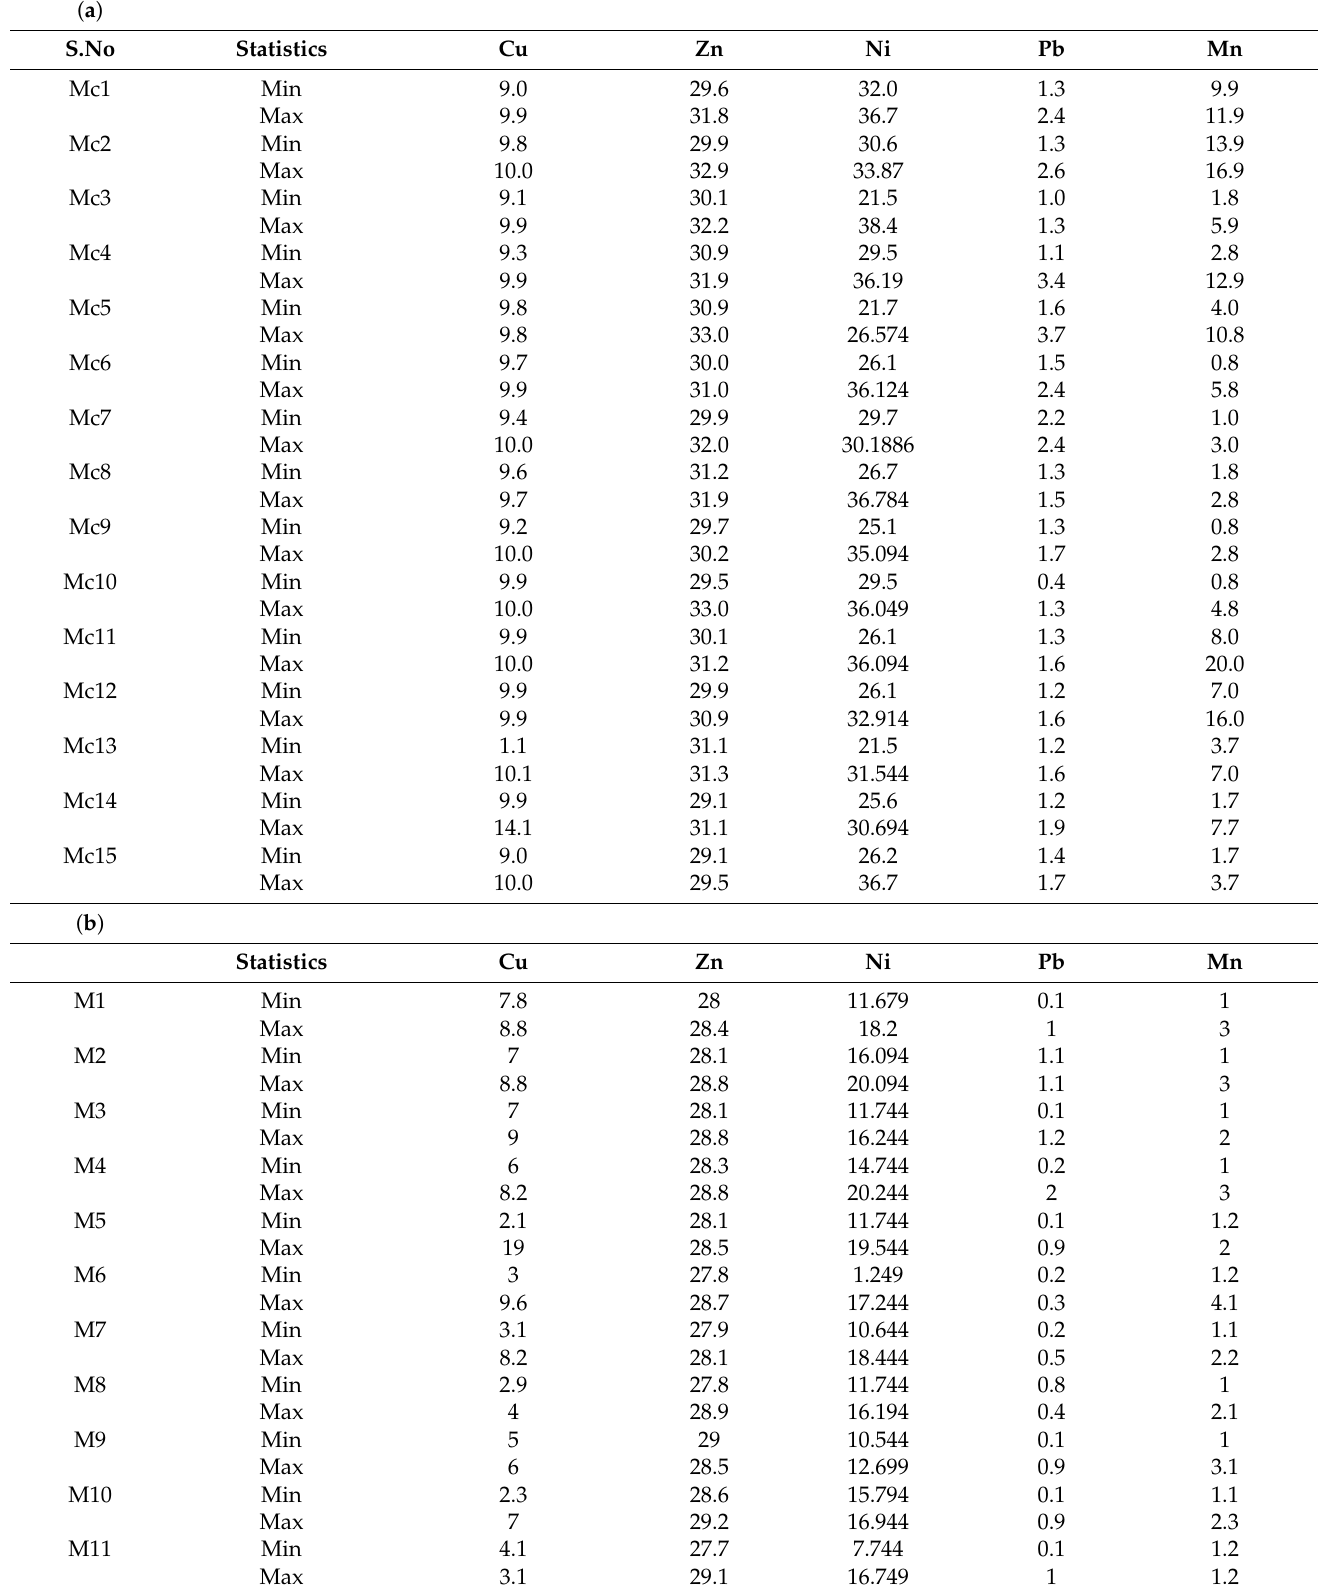
Table 2. ( a ) Heavy metals concentration (mg/kg) in Morels fruiting body (FB). ( b ) Heavy metals concentration (mg/kg) in Morels hymenophore (H). ( c ) One-way ANOVA results showing the concentration of heavy metals translocating from soil to hymenophore and fruiting body (mg/kg) in M. galileae